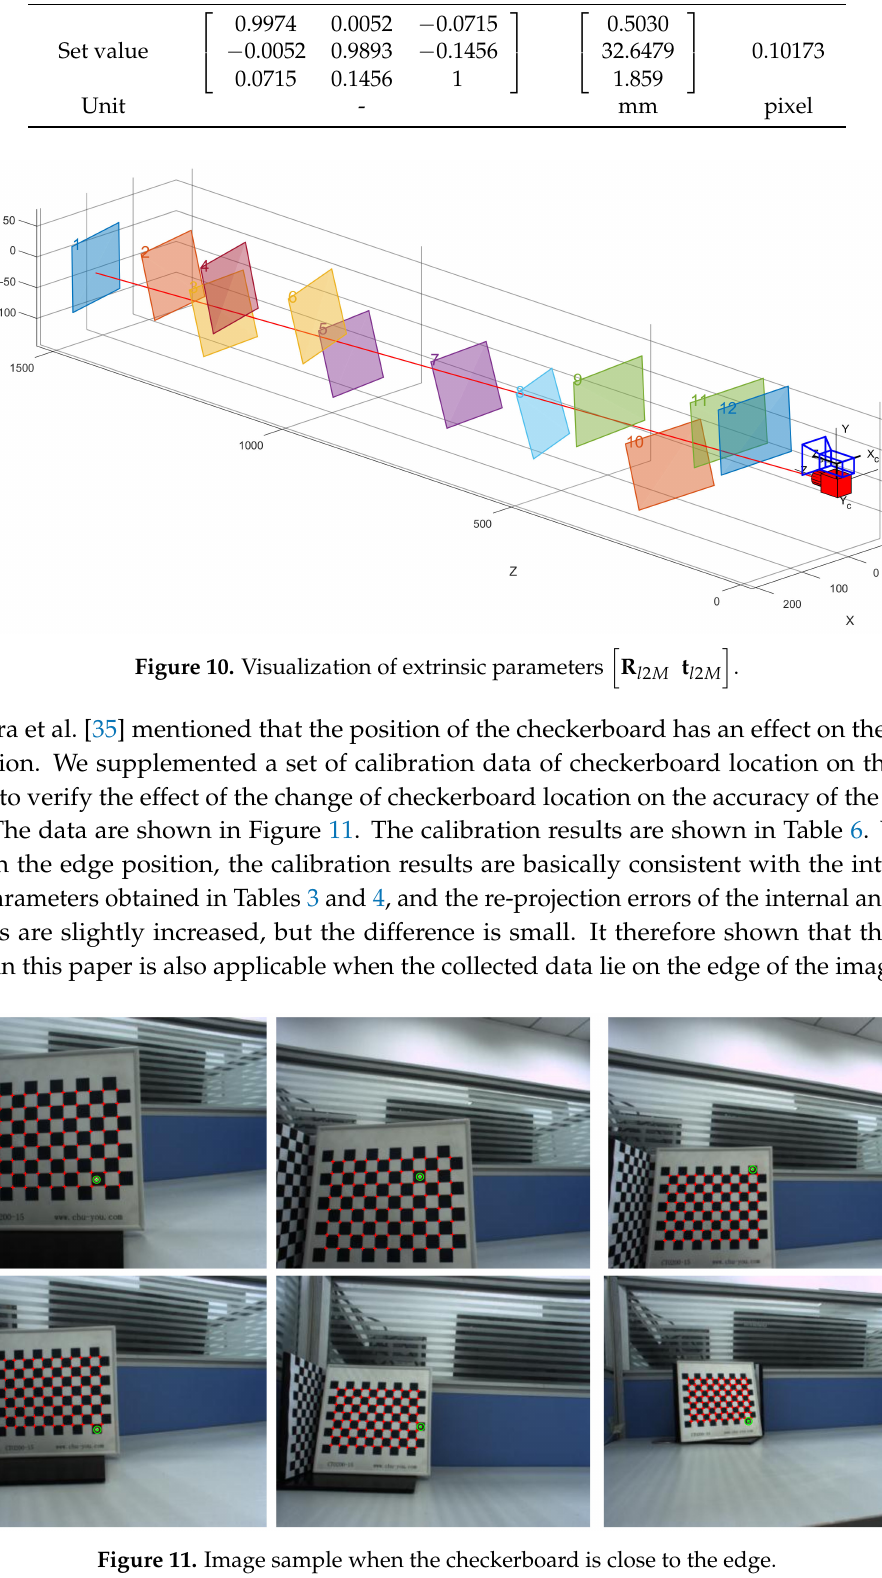
Figure 11. Image sample when the checkerboard is close to the